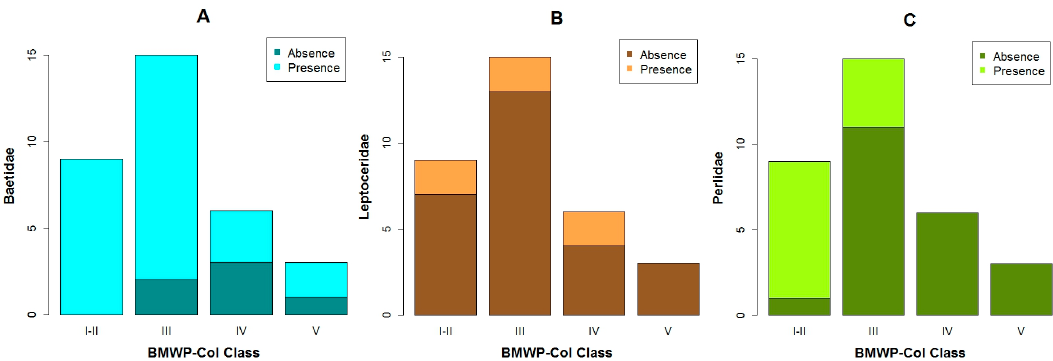
Figure 4. Bar plots of the BMWP-Col class with the number of the samples in which the chosen macrobenthos were present or absent: ( A ) Baetidae ; ( B ) Leptoceridae and ( C ) Perlidae . Table 2. Spearman correlation coefficients of the explanatory variable used to construct the generalized linear models (GLMs).